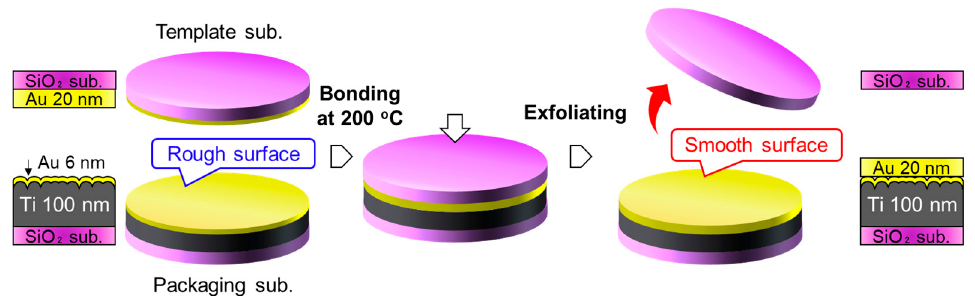
Figure 2. TS process for fabrication of smooth getter layer on packaging substrate.